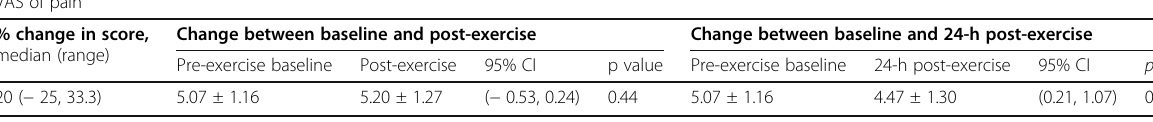
Table 3 Comparison between pain score at baseline, post-exercise, and 24 h after VAS of pain % change in score, median